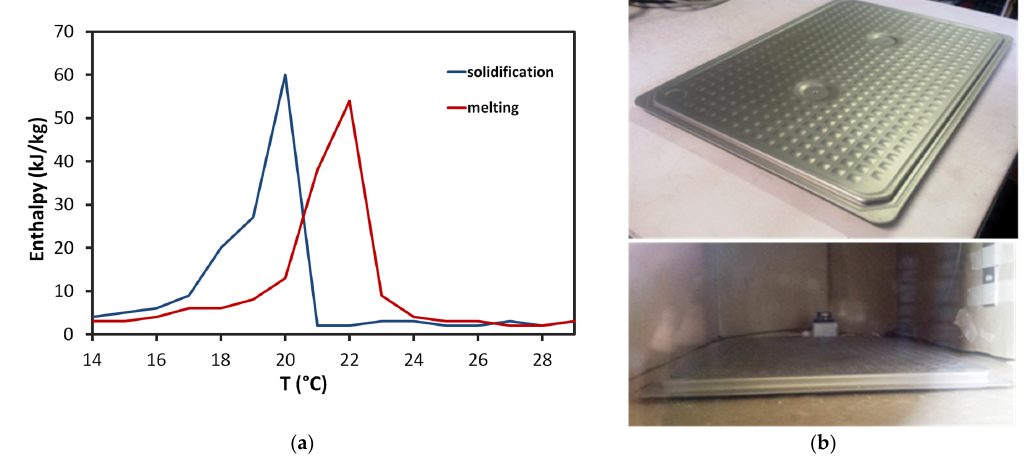
Figure 3. ( a ) Enthalpy—temperature curves for melting and solidification for the SP21E board tested; ( b ) SP21E panel and the panel laid on the STB floor. ( b ) SP21E panel and the panel laid on the STB